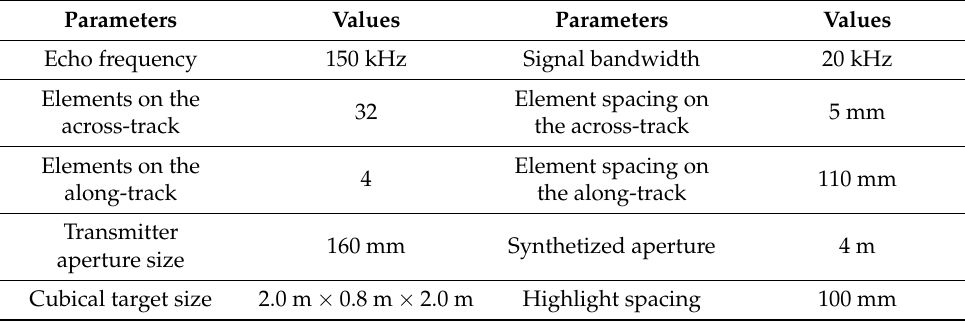
Table 1. Solid target simulation